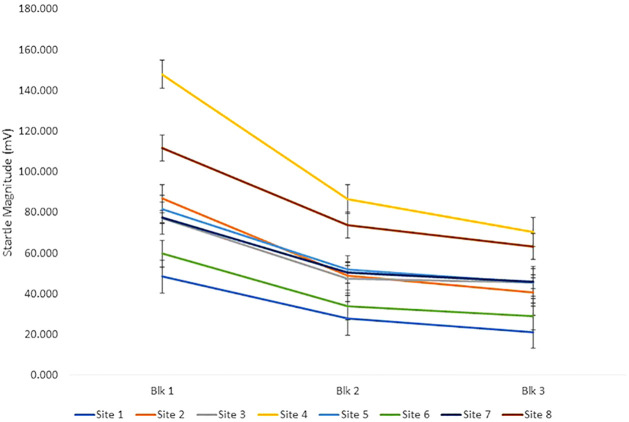
The figure shows startle magnitude to pulse alone stimuli across the three blocks of the startle session across all 8 sites. There were significant site effects despite equivalent equipment, calibration, and methods across sites.